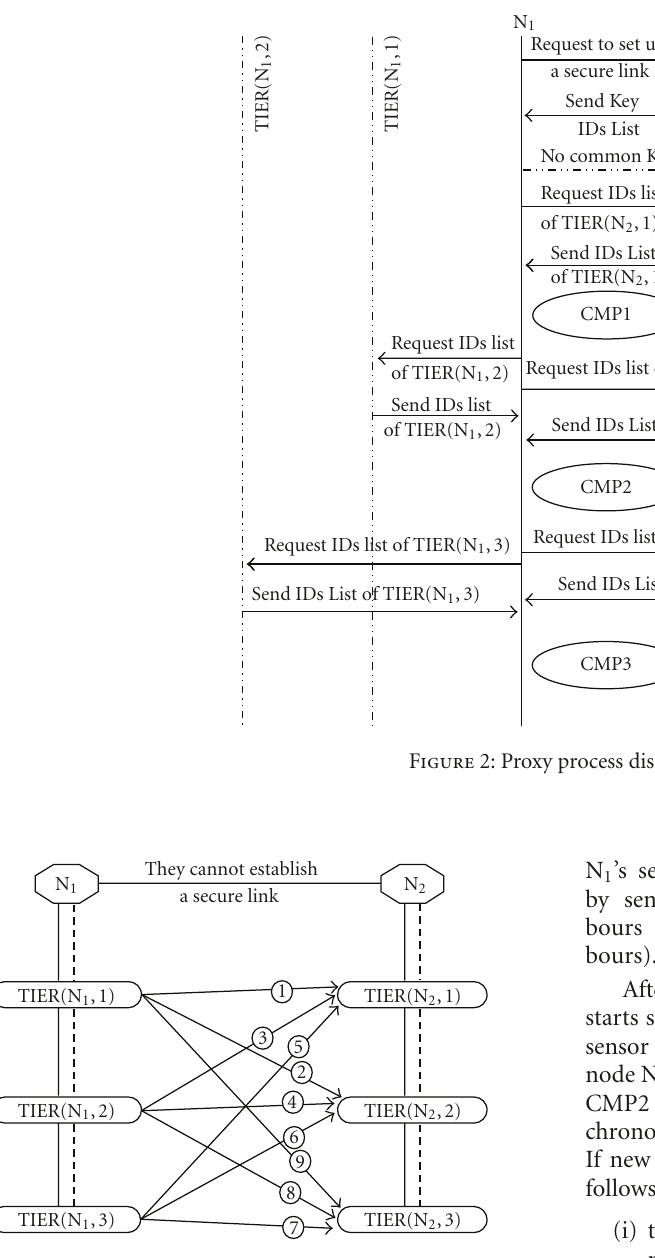
Figure 3: Chronological sequence comparison for proxy process